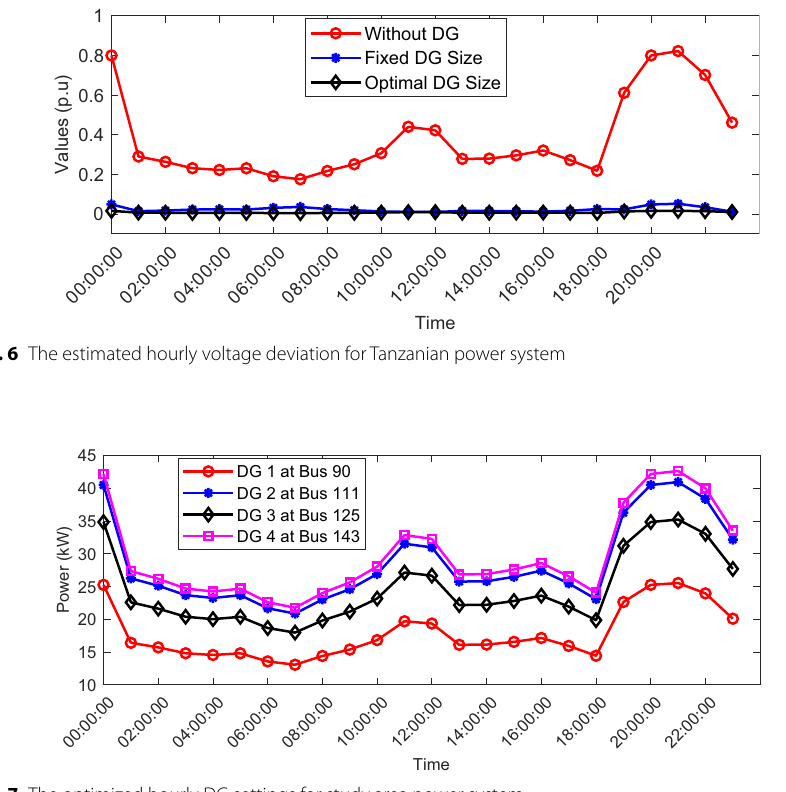
Fig. 7 The optimized hourly DG settings for study area power